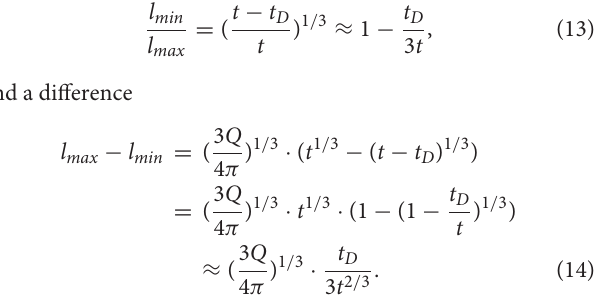
Frontiers in Physics |